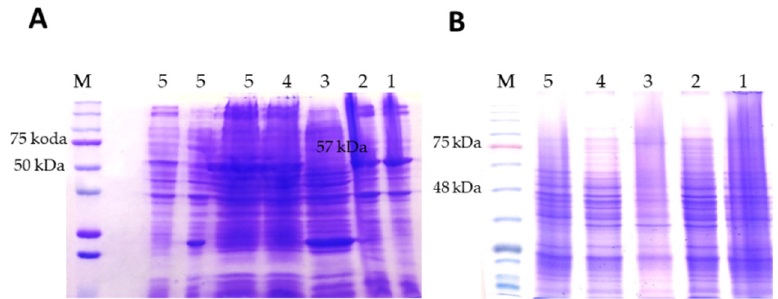
Figure 1. Gel electrophoresis analysis of the expression of rhPEPD. Dominant bands were identified by the mass size corresponding to the 57 kDa of rhPEPD as a monomer. Expression with 1 mM IPTG: lines 1–5 correspond to attempts 1–5; ( A ) the pellet after sonication of bacterial culture was analyzed (protein in inclusion bodies); ( B ) soluble fraction.